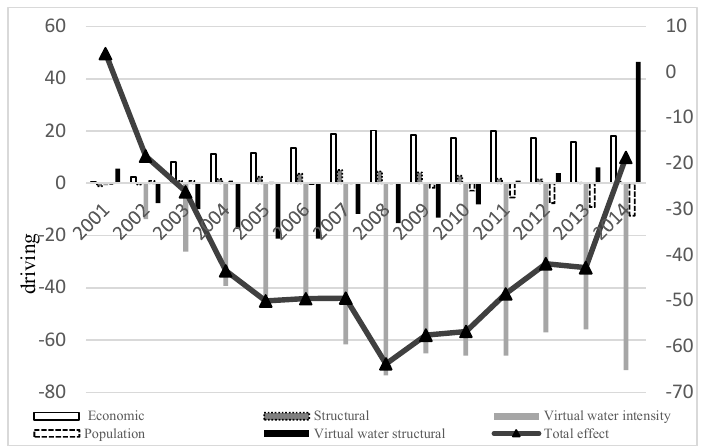
Figure 5. Decomposition of factors affecting the virtual water consumption, 2000–2014.